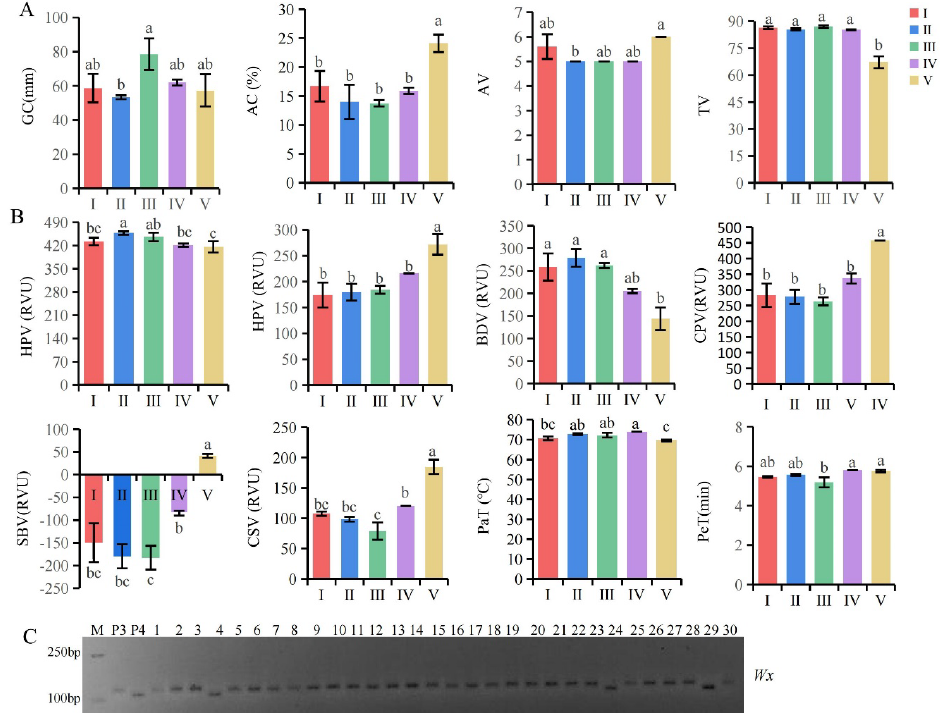
Fig. 6: Cooking and eating Quality performance. A, Statistical analysis of Gel consistency (GC), Amylose content (AC), Alkali value (AV), Taste value (TV) Based on Cluster Analysis; B, Statistical analysis of RVA spectrum characteristic values Based on Cluster Analysis. C, Electrophoresis pattern of test genotypes including resistant/tolerant check (P3) and susceptible check (P4) using Wx genes linked markers. M: marker (100-2000bp); P3: Xiangyaxiangzhan, P4: Yuexiangzhan.